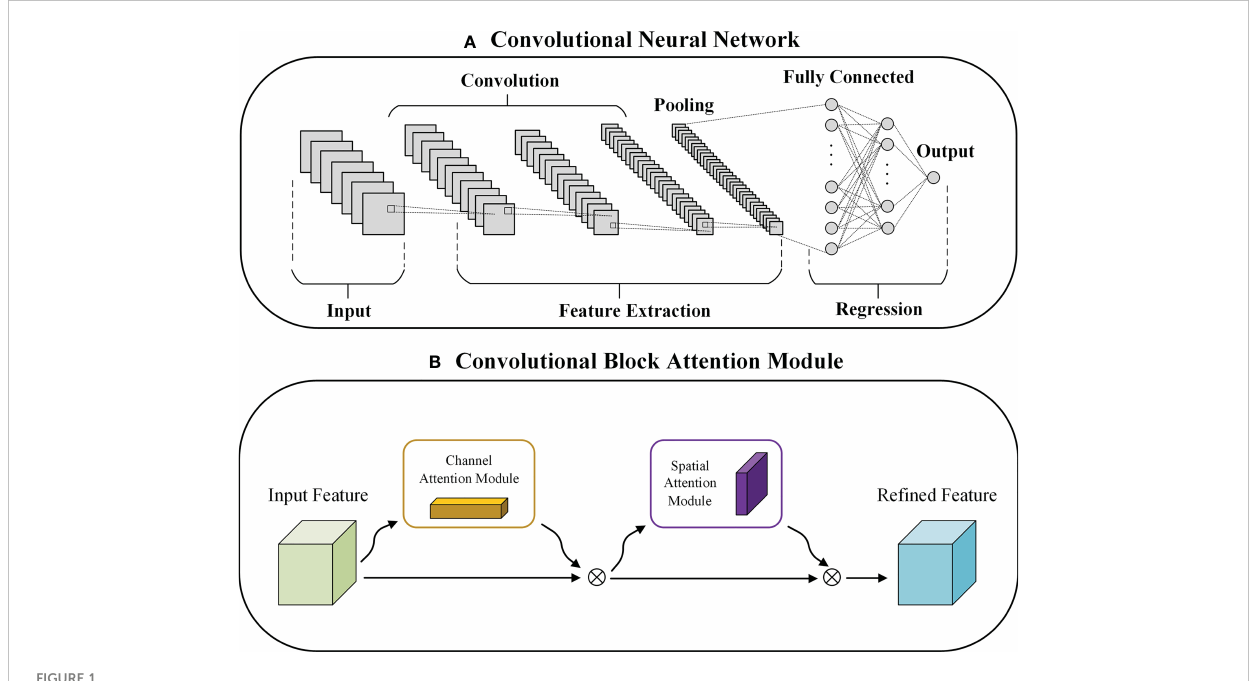
FIGURE 1 Structure of (A) CNN model and (B) CBAM